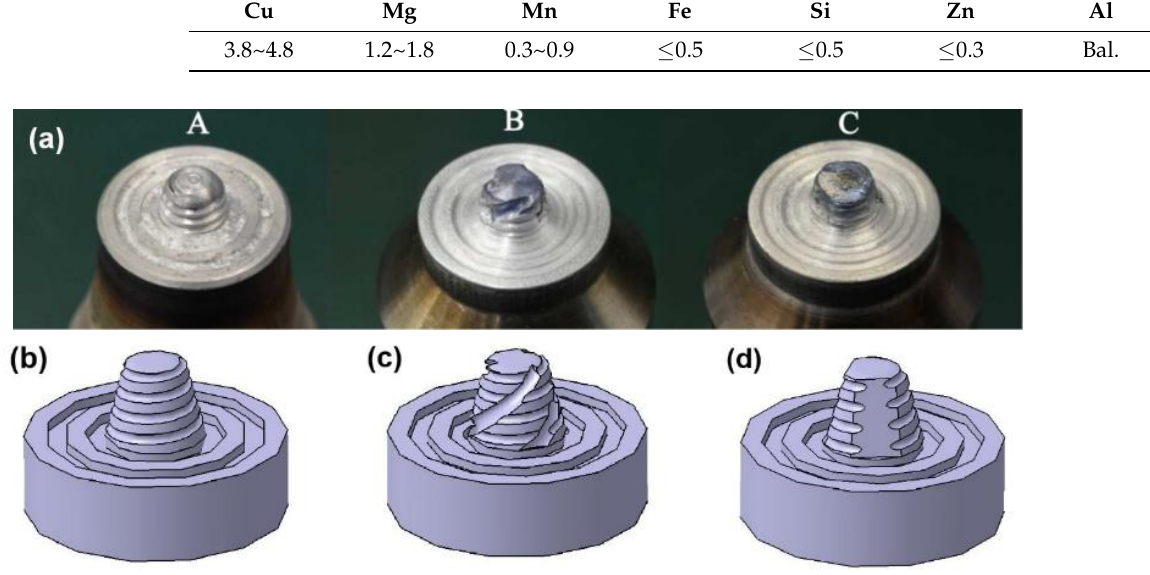
Figure 2. Geometries of three kinds of tool pins: ( a ) actual shapes of pins, ( b ) conical thread, ( c ) deep groove thread, ( d ) conical cam thread.